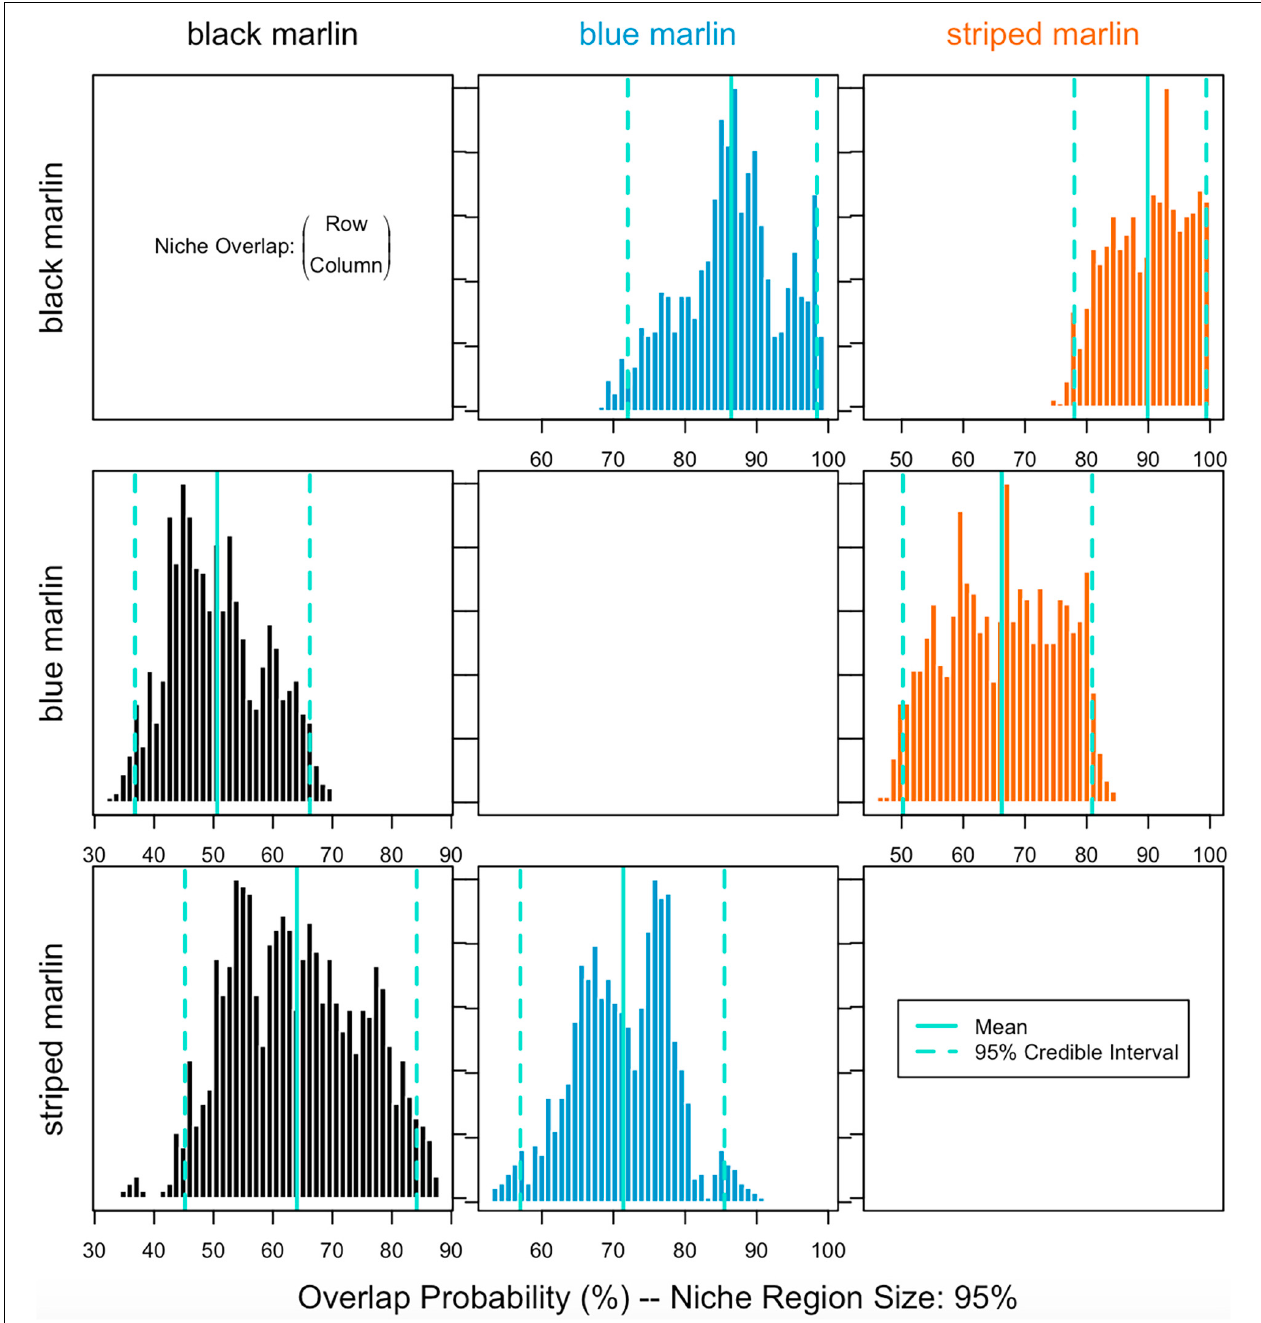
FIGURE 3 | Probability of individual marlin isotope values of placing it within the isotopic niche of another marlin species (1,000 runs with probability level of alpha = 95%) for three marlin species: black marlin ( Istiompax indica ), blue marlin ( Makaira nigricans ), and striped marlin ( Kajikia audax ).